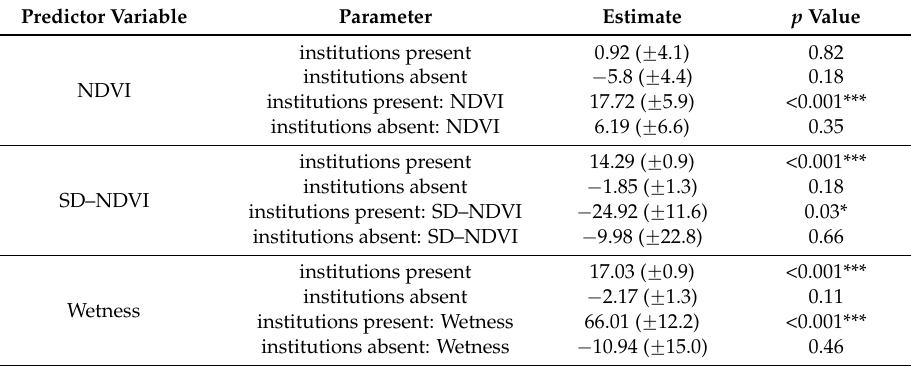
Table 4. Results of the quantile regression for species richness (tau = 0.95) in the villages with presence and absence of the local forest institutions.